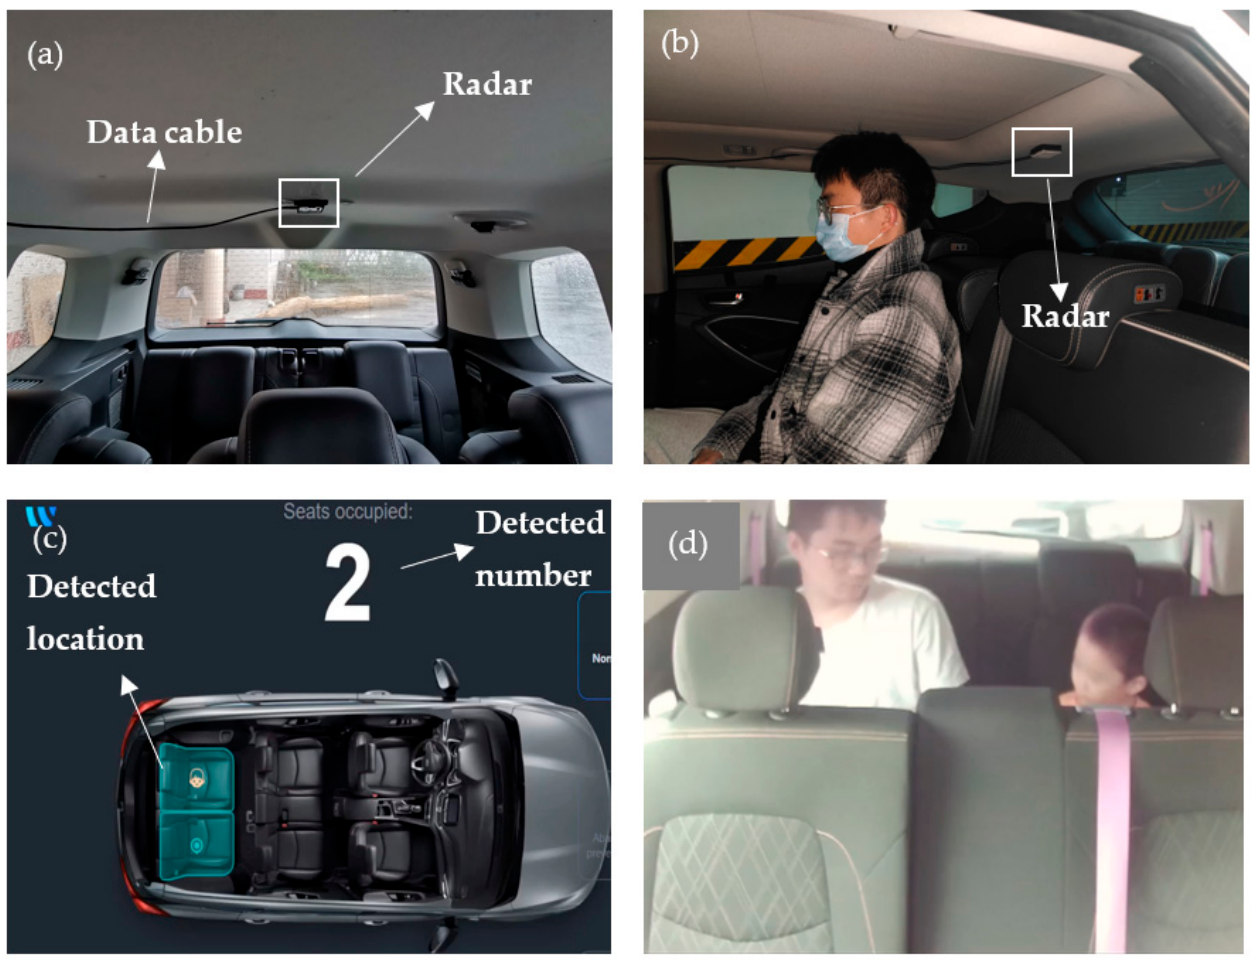
Figure 12. Radar placement and experimental environment: ( a ) front view of the radar mounting position; ( b ) left view of passenger and radar; ( c ) the interface where the results are presented. Where the number of people is marked in the upper part and the location of the passengers are marked in the vehicle ( d ) live in-vehicle view of the test case with one adult and one child in the third row.